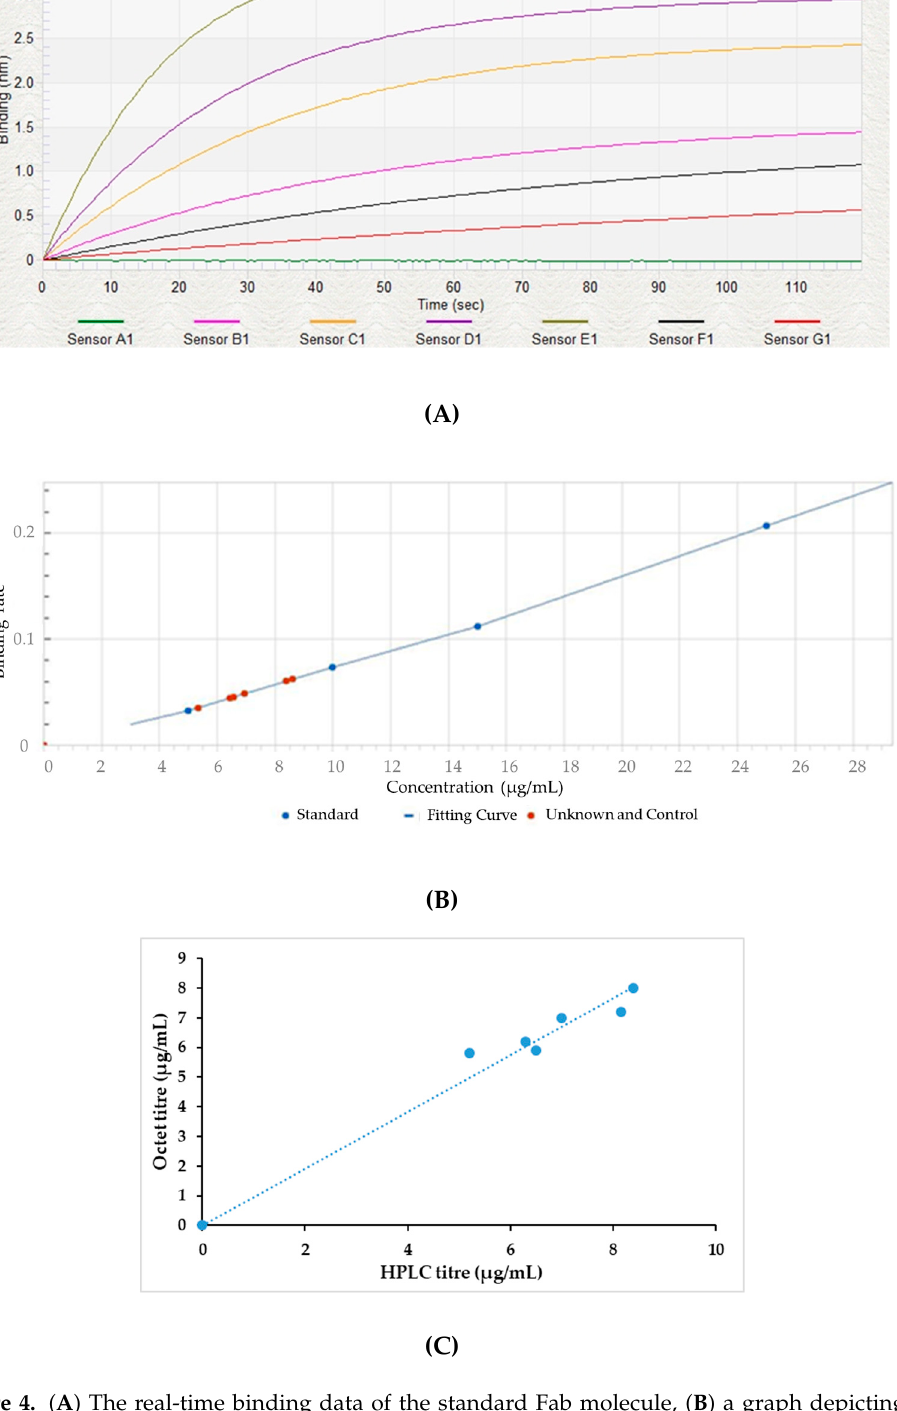
Figure 4. ( A ) The real-time binding data of the standard Fab molecule, ( B ) a graph depicting the binding rate of the standard as well as target Fab protein, ( C ) the comparison of Fab protein measured by Octet and RP-HPLC methods.